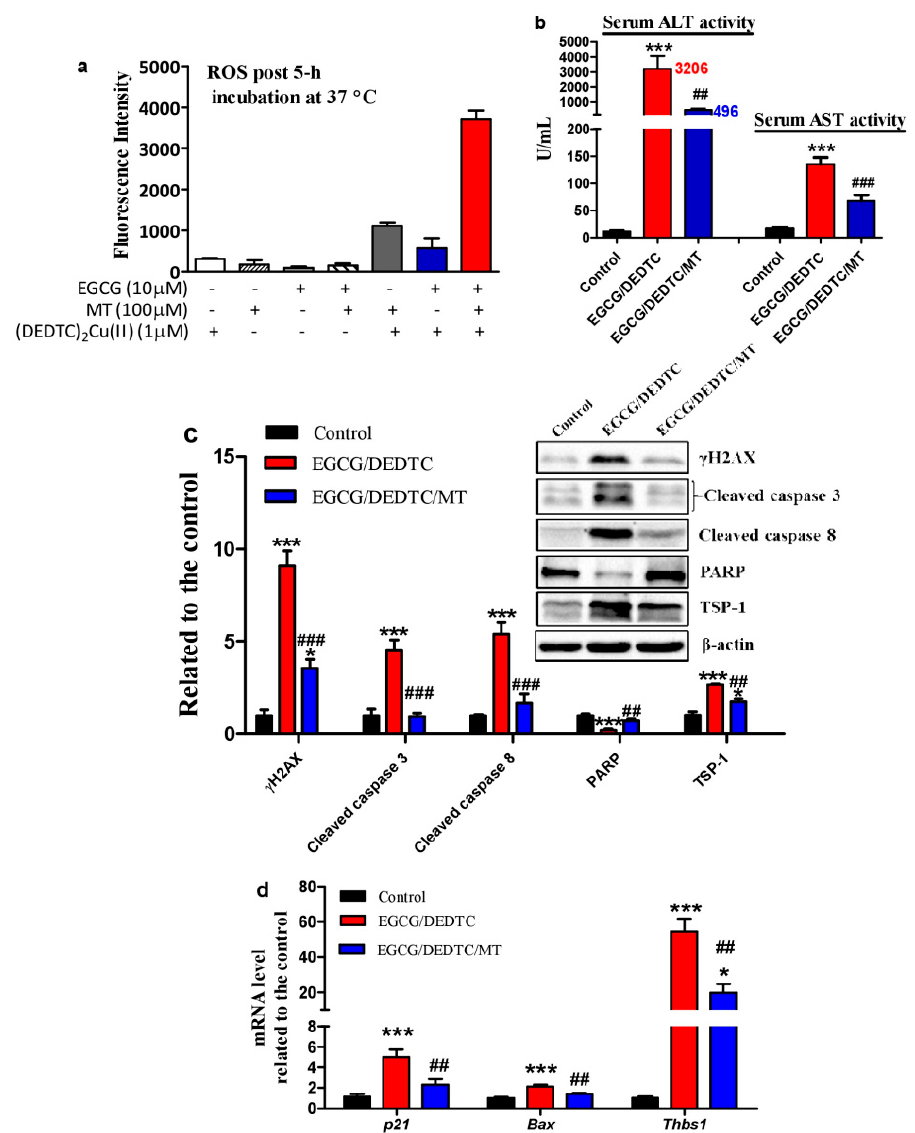
Figure 9. Influences of melatonin on ROS production by EGCG and Cu(DEDTC) 2 in vitro and oxidative stress induced by EGCG and DEDTC in mice. In-vitro experiment : ( a ) Melatonin (MT) enhanced ROS formation of (DEDTC) 2 Cu(II) and EGCG. Chemicals were mixed in 0.05 M PBS (pH 7.4) and incubated at 37 °C. In-vivo experiment : Mice were treated with saline as control, EGCG/DEDTC as model of liver injury, and EGCG/DEDTC/MT (drug regimens are described in Materials and Methods). ( b ) Serum ALT and AST activities. ( c ) Hepatic proteins associated with DNA damage, apoptosis and prosurvival effects of nitric oxide. ( d ) p53-associated genes. Data are presented as mean ± SEM (n = 6). Compared to the control, * P < 0.05 and *** P < 0.001. Compared to the DEDTC/EGCG, ## P < 0.01 and ### P < 0.001. The serum ALT, AST activity ( b ) and Thbs 1 mRNA level ( d ) were analyzed by one-way ANOVA post hoc Dunnett test. The other data ( c , d ) were analyzed by one-way ANOVA post hoc Tukey’s test.